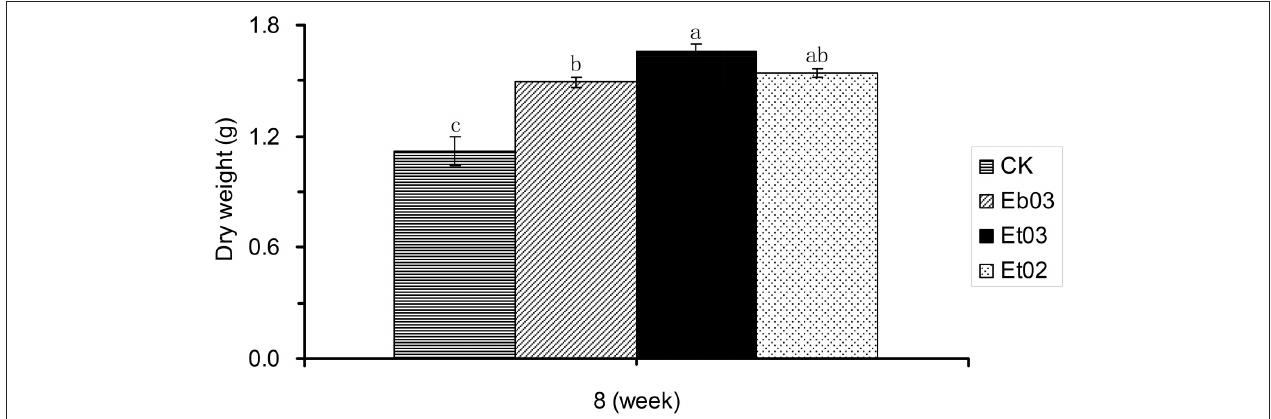
FIGURE 3 | Effects of Epichloë endophyte on dry weight of Elymus sibiricus . Significant differences at the 0.05 level are indicated within a time by different letters above bars. Values are means of five replicates ± SE.